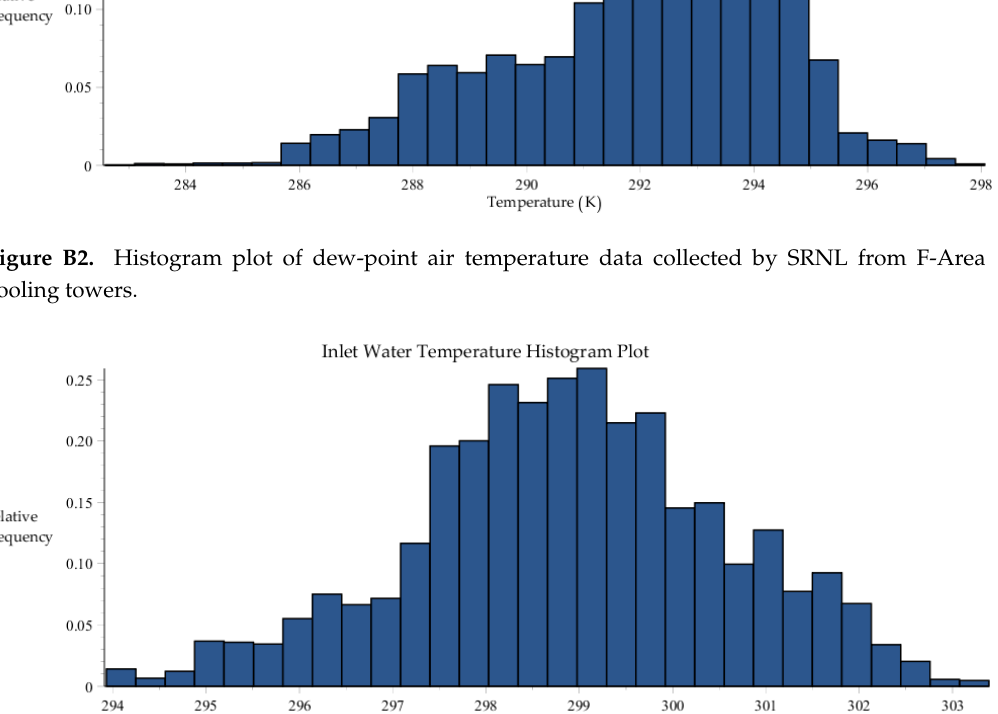
Figure B3. Histogram plot of inlet water temperature data collected by SRNL from F-Area cooling towers.